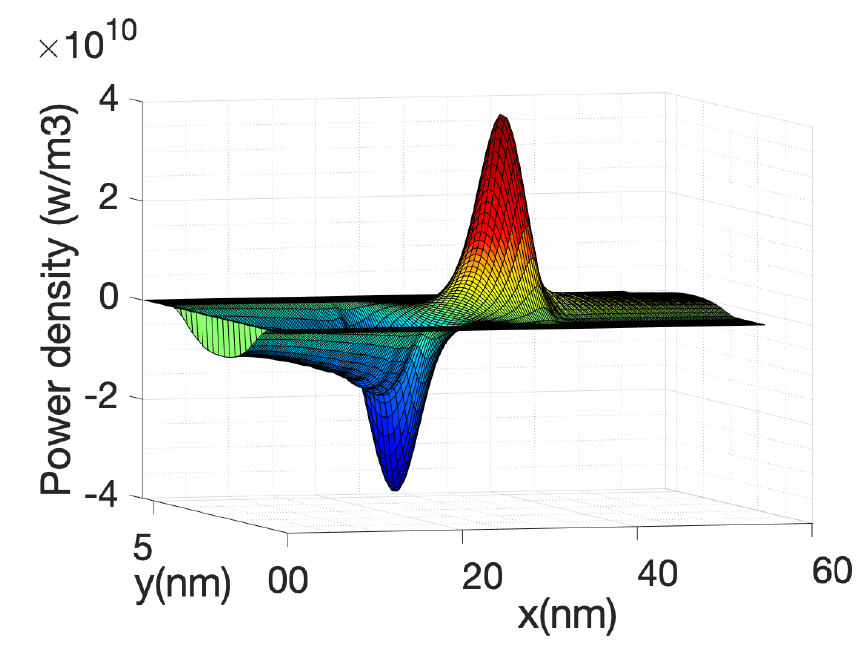
Figure 11. Power density profile used as heat source in the heat equation.The gate potential (Vg) and drain potential (Vd) are 0.3V and 0.6 V, respectively. This figure shows the 2D profile of the 3D analogue of the total power showed in Figure 6. Positive values indicate source of heat and negative values sink of heat or cooling.